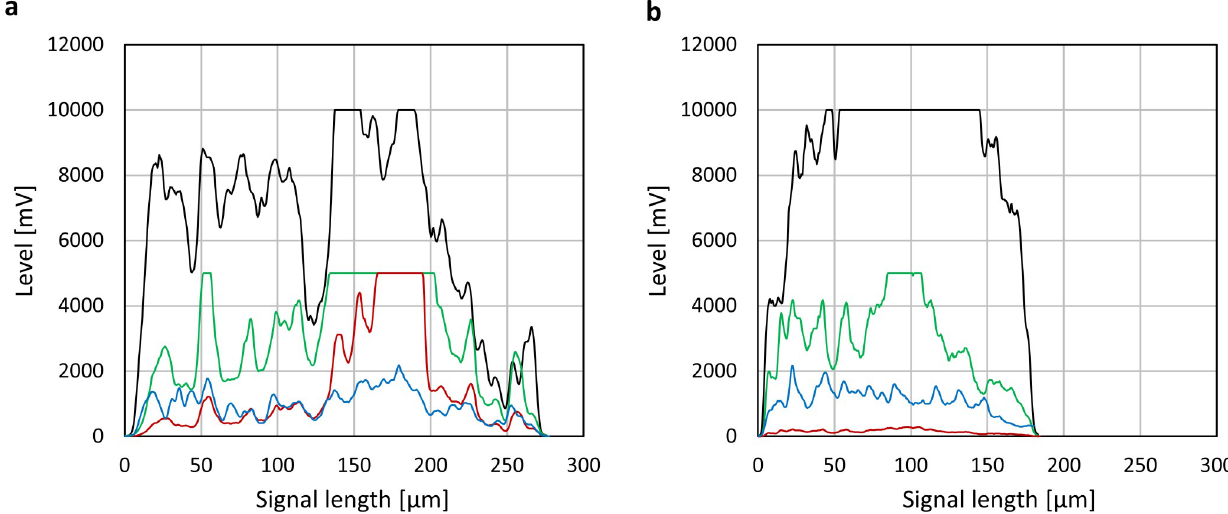
Fig 6. Exemplary signal profiles of flow cytometry measurements including FSC (black), SSC (blue), green fluorescence (green) and red fluorescence (red) data. Cultivation (a) without and (b) with glass beads. The pellet’s core is identified via FSC and SSC signal saturation. “Length of SSC signal” (Eq (5)) is based on the signal length at half of the maximum of the signal level of the signal profile. To compensate for increased signals at high pellet sizes, “Length of SSC signal” is divided by “Signal length” which represents the overall diameter of the pellet as displayed on the X-axis.